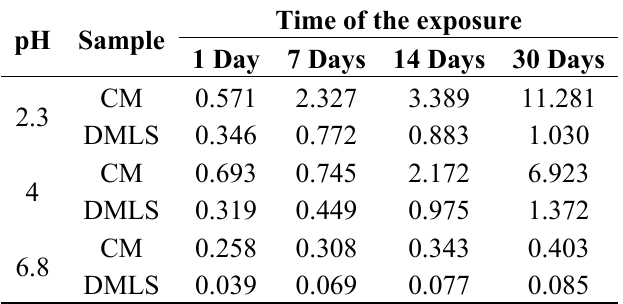
Table 5. Total release of Co, Cr and Mo from the CM and DMLS alloys (μg per cm 2 ) in artificial saliva of pH = 2.3, pH = 4 and pH = 6.8.